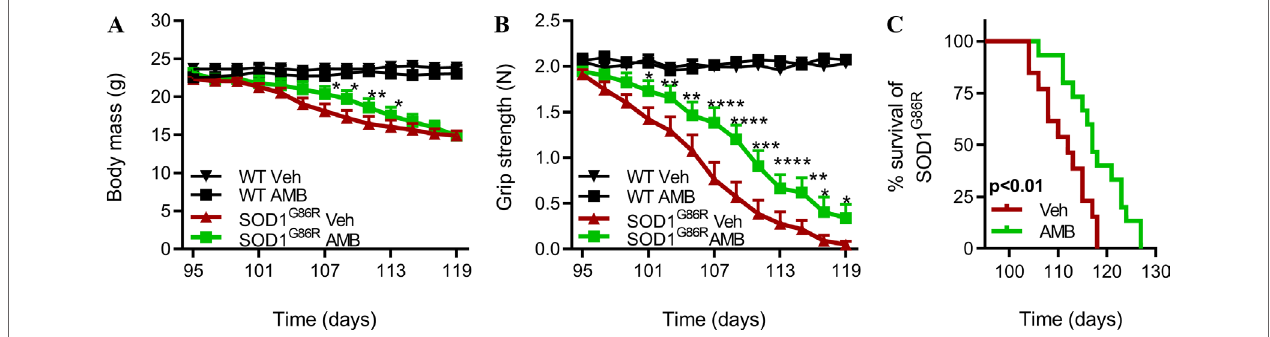
FIGURE 3 | AMB delays disease onset and improves motor functions in symptomatic SOD1 G86R mice. (A) Body mass evolution in SOD1 G86R and WT mice ( n = 12–15/group). (B) Muscle strength evolution in SOD1 G86R and WT ( n = 12–15/group). (C) Kaplan–Meier analysis of SOD1 G86R mice survival ( n = 13–15/group,